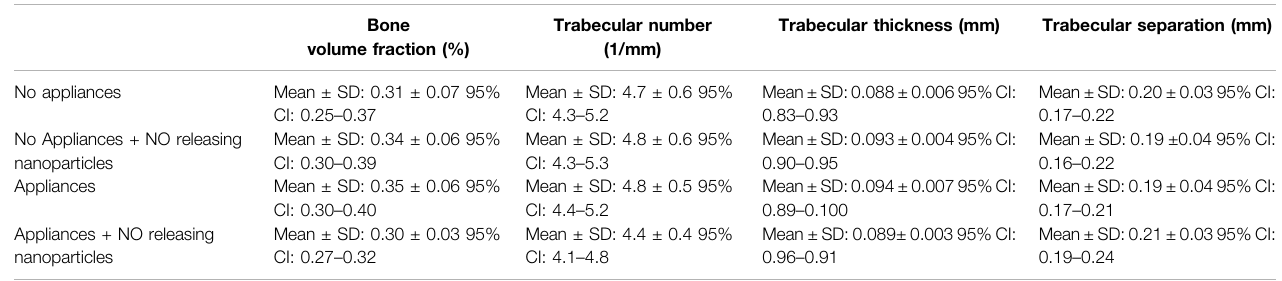
TABLE 2 | Trabecular bone quality measures.